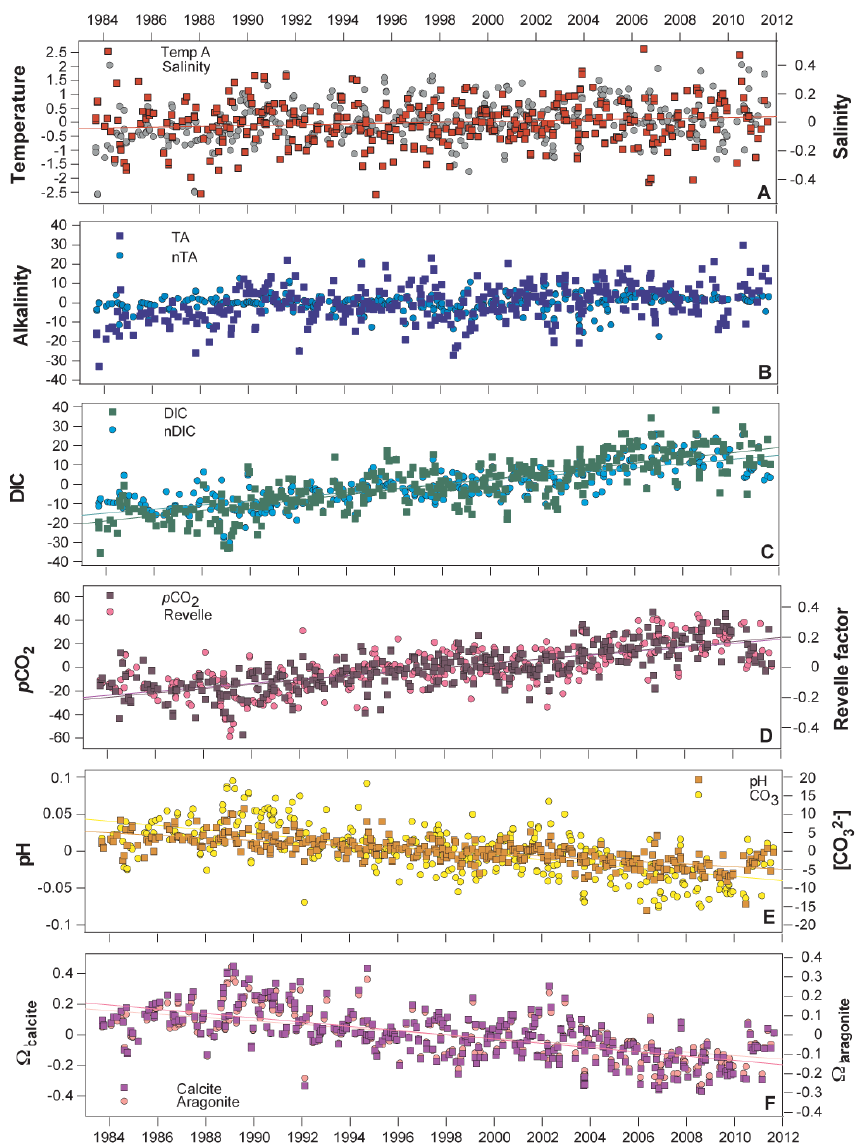
Fig. 6. Long-term anomalies and trends of surface hydrography, seawater carbonate chemistry and ocean acidification indicators from 1983 to 2011 at the BATS (Bermuda Atlantic Time-series Study; 31 ◦ 40 0 N, 64 ◦ 10 0 W) and Hydrostation S (32 ◦ 10 0 N, 64 ◦ 30 0 W) sites located near Bermuda in the NW Atlantic Ocean. Slopes and statistics of regressions are listed in Table 1. (A) Sea surface temperature ( ◦ C; black line) and salinity (red line). (B) Surface total alkalinity (TA,µmolkg − 1 , blue symbol) and salinity normalised TA (nTA;µmolkg − 1 , cyan symbol). (C) Surface dissolved inorganic carbon (DIC,µmolkg − 1 ,green symbol) and salinity normalised DIC (nDIC;µmolkg − 1 , cyan symbol). (D) Seawater p CO 2 (µatm; purple symbol) and Revelle factor ( β) (salmon symbol). (e) Surface seawater pH (orange symbol) and [CO 2 − (µmolkg − 1 , yellow symbol) (f) Surface saturation state of calcite ( (cid:127) calcite ) (purple symbol) and aragonite ( (cid:127) calcite ) (light pink symbol).